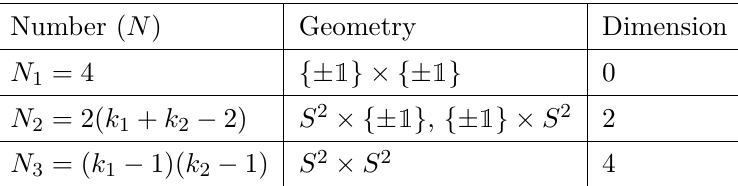
× SU (2) k . Note that N 1 + N 2 + N 3 = 1 2